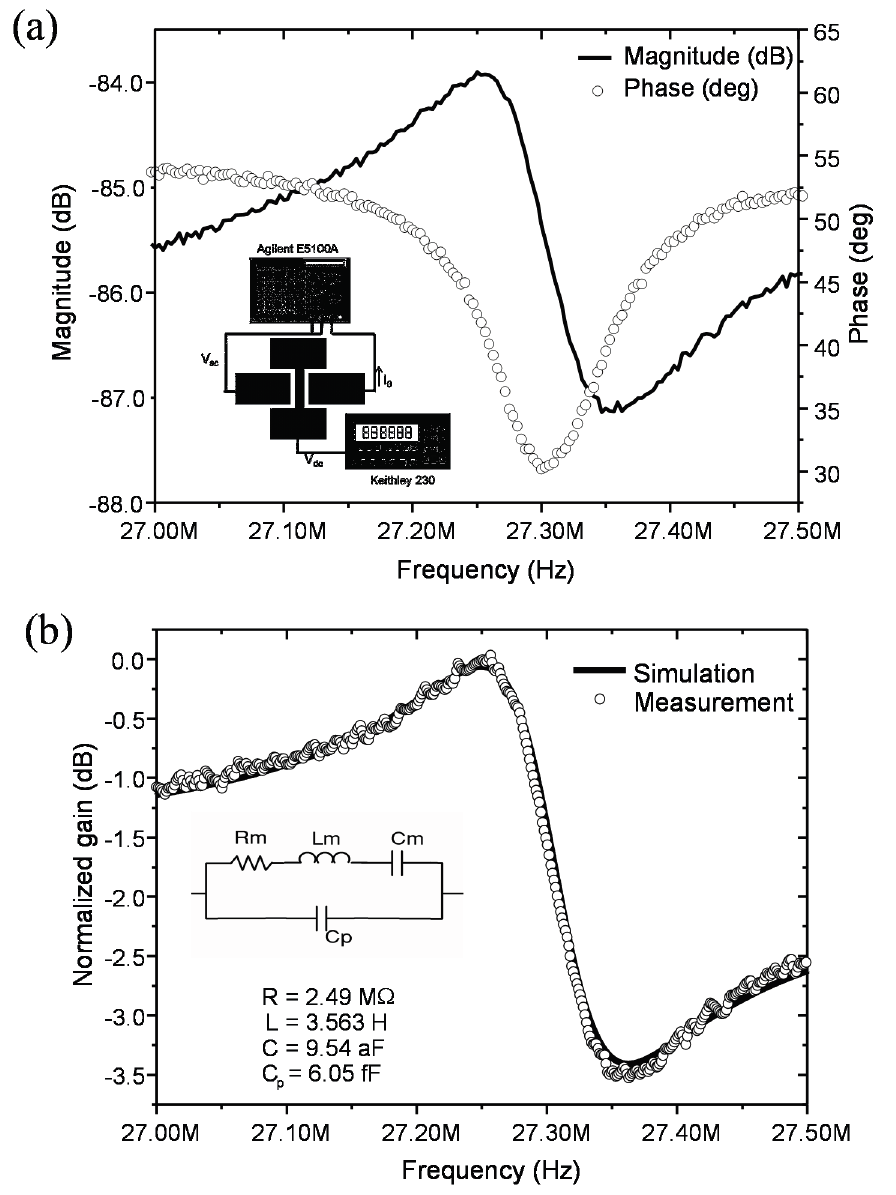
Figure 2. ( a ) Experimental frequency response (magnitude and phase) and Electrical characterization set-up for capacitive actuation and sensing; ( b ) Fitting of the experimental frequency response with the electrical equivalent circuit shown in the